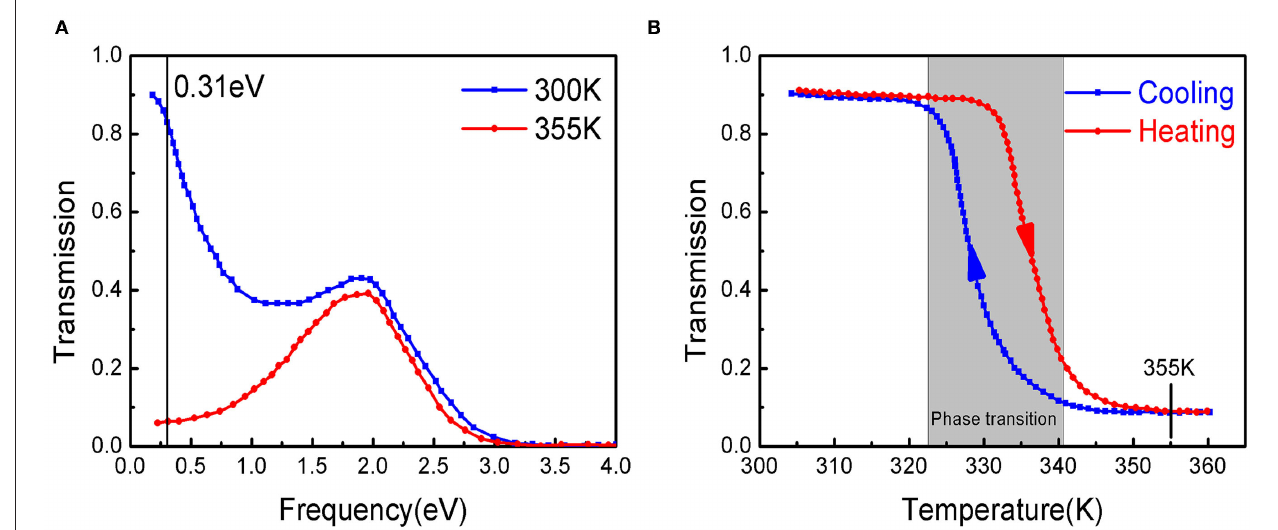
FIGURE 3 | (A) Schematic diagram of the lens structure, composed of two areas A and B. (B) A schematic diagram of linearly polarized light focusing along the z direction after passing through the lens. (C) Schematic of the building block, The metalens consists of VO 2 nanofins on a glass substrate. (D,E) Side and top views of the unit cell showing height H, width W, and length L of the nanofin, with unit cell dimensions P angle θ , according to the geometric Pancharatnam-Berry phase.